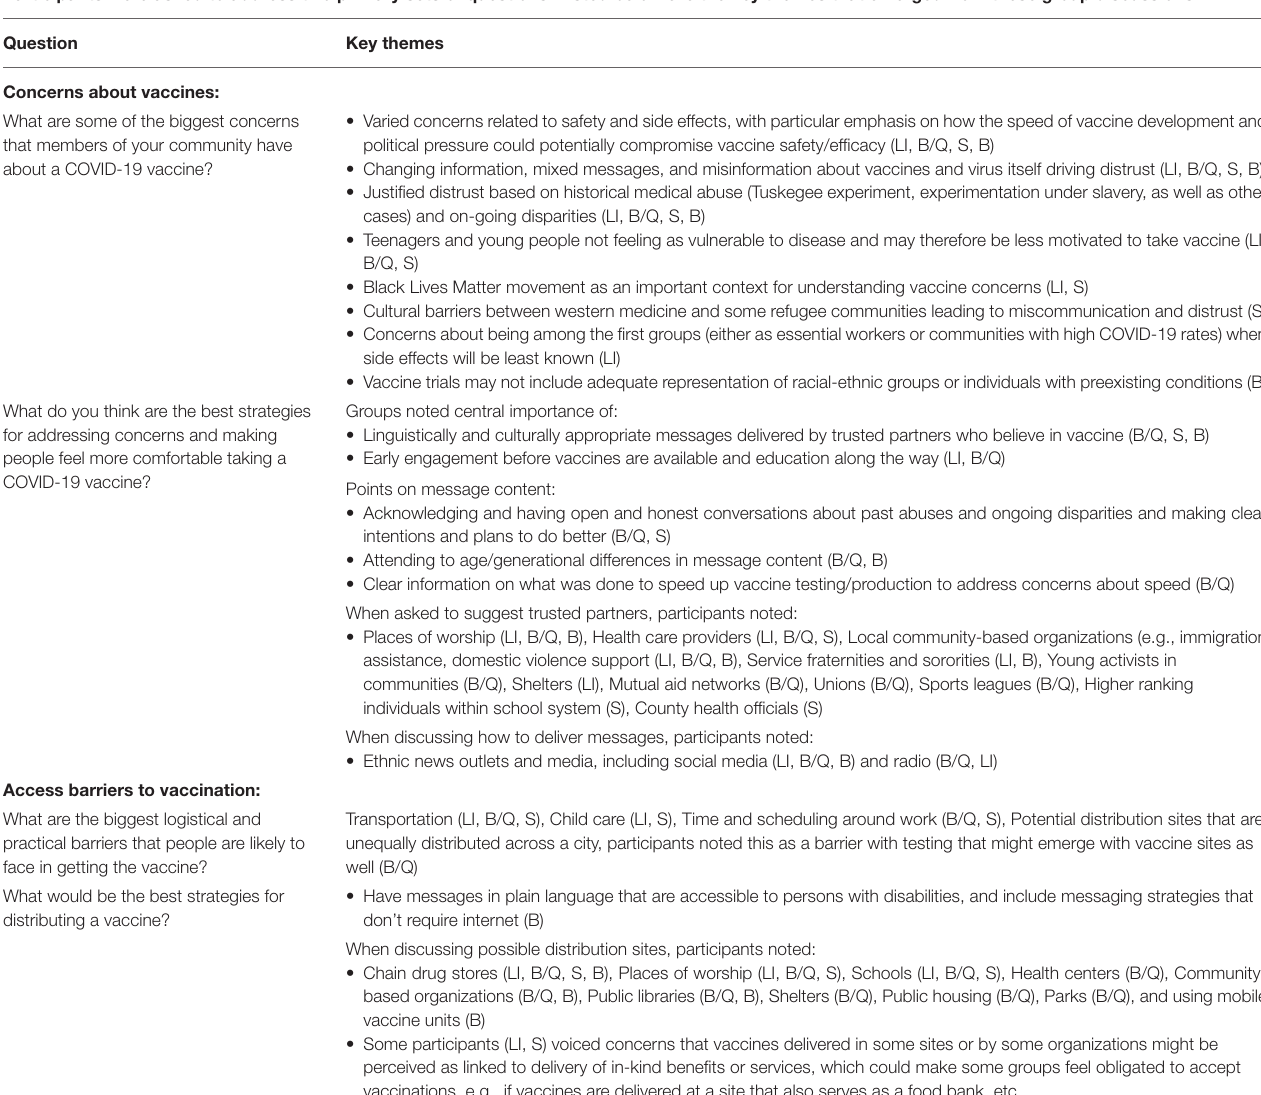
TABLE 2 | Primary questions and key themes of